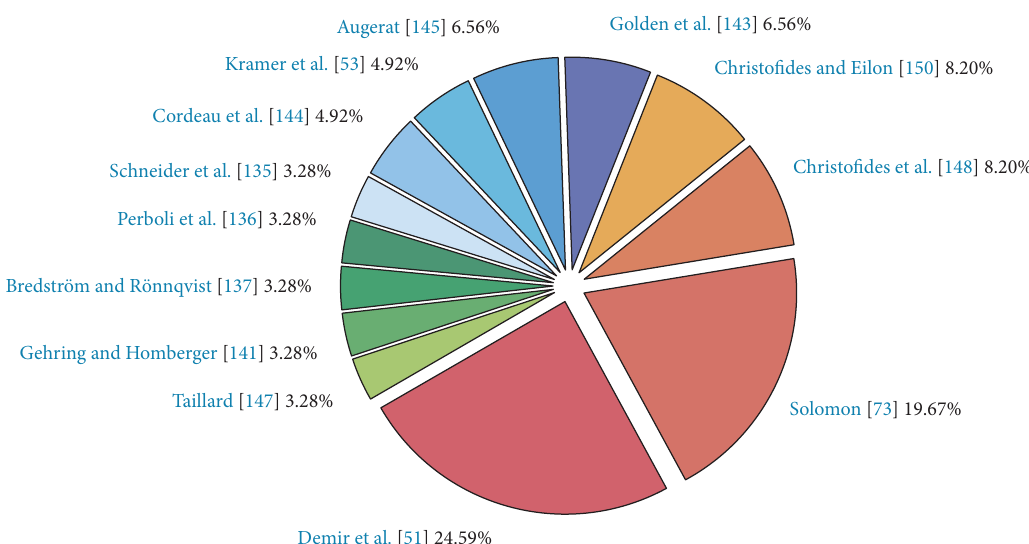
Figure 7: Pie chart of the different benchmarks used for GVRPs. +e pie chart visualizes the utilization percentage of each benchmark instances for the reviewed